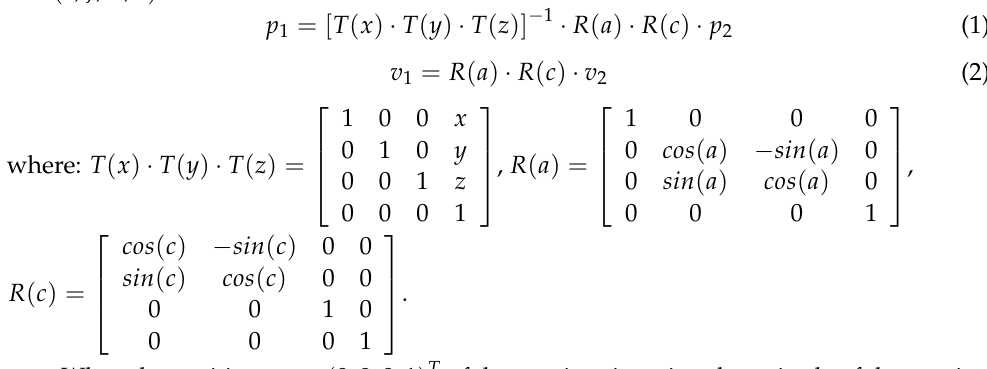
Figure 3. A and C axes’ geometric error elements .